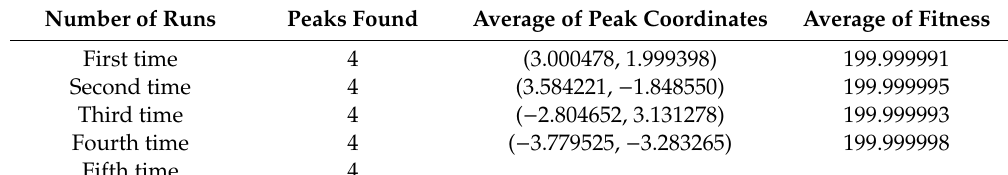
Table 4. Results of IAFSA and AFSA optimize f 3.